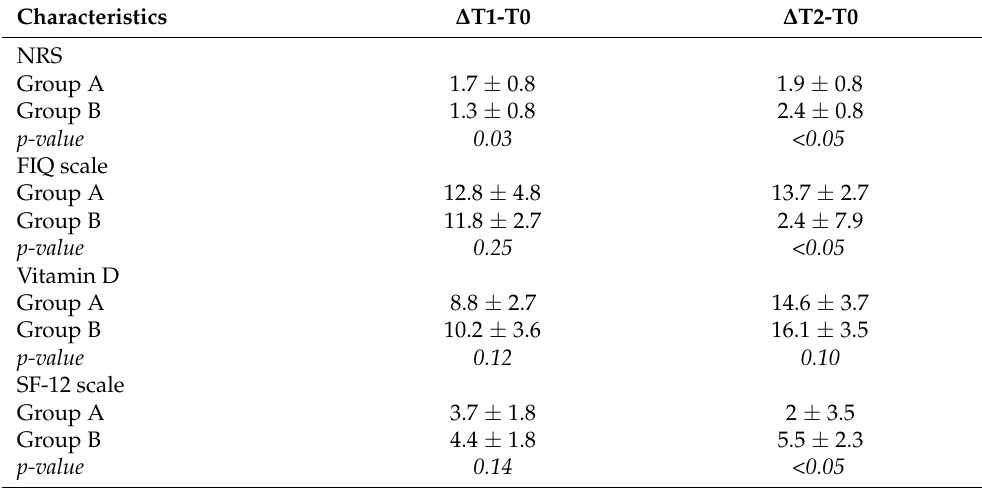
Table 6. Comparison between the T1-T0 ( ∆ T1-T0) and T2-T0 ( ∆ T2-T0) variations between the two groups at 3 months (T1) and at 6 months